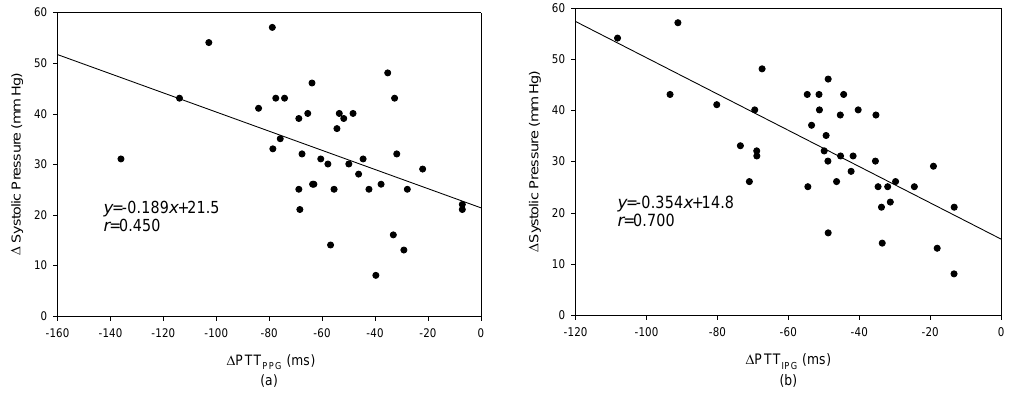
Figure 11. The result of the PTT PPG and diastolic pressure. ( a ) The relationship between the PTT PPG and diastolic pressure, r = 0.350; ( b ) The relationship between the PTT IPG and diastolic pressure, r = 0.332.